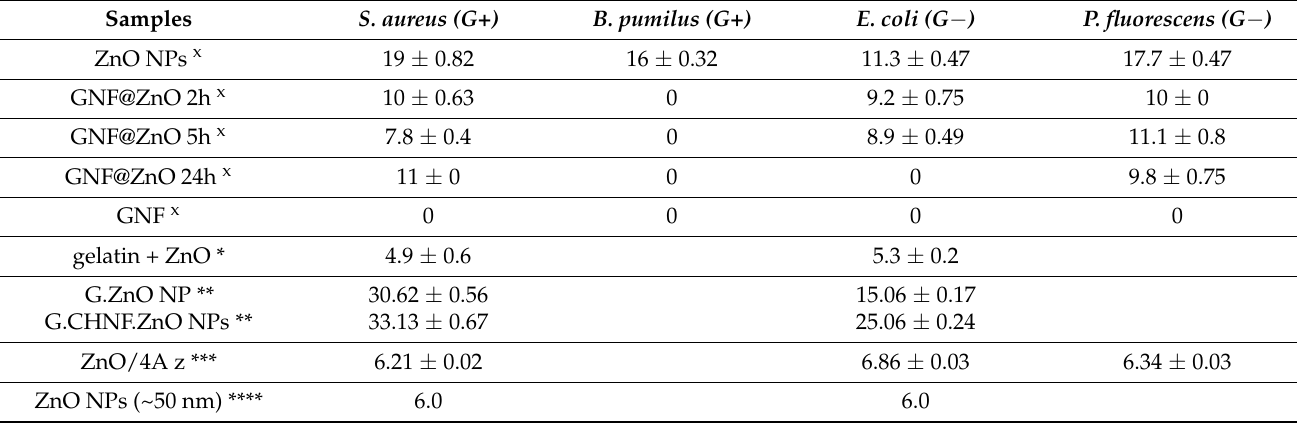
Table 3. Mean diameter of the zone of inhibition (in mm, including the 6 mm diameter of the disk) after ZnO NPs, GNF, and GNF@ZnO composites